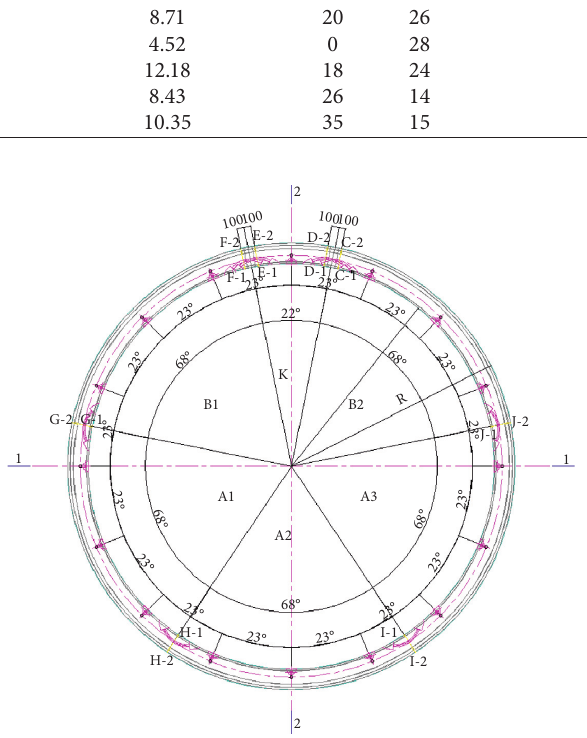
Figure 5: Structure of existing tunnel lining. Table 2: Parameters of the linings.